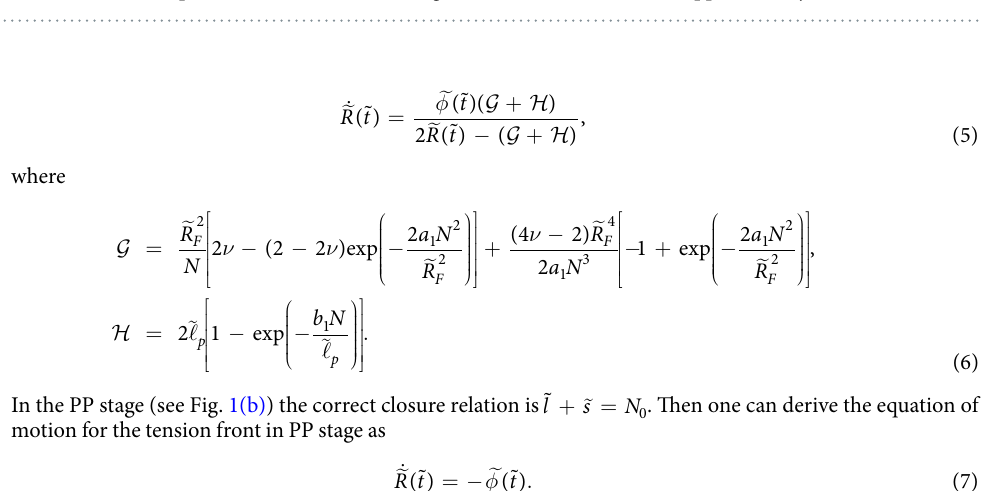
Figure 3. The trans side friction η  s ( ) as a function of  s for fixed values of the chain length N 0 = 64, bending TS rigidity κ b = 30, and external driving force f = 20. The turquoise circles are MD data. The blue solid, dashed and dashed-dotted lines represent the three different regimes (see the text and the Supplementary for